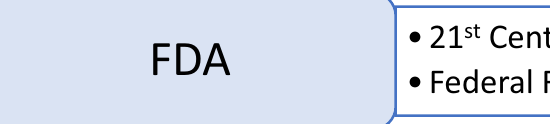
Regulatory framework in the USA on medical devices